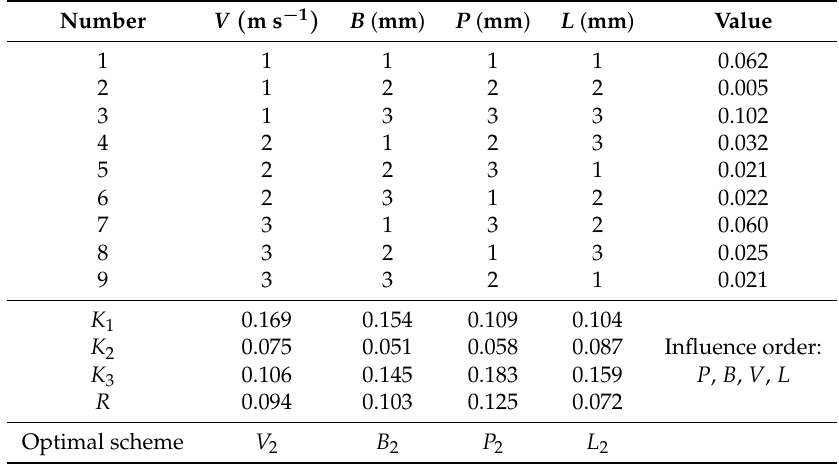
Table 4. Simulation results of index λ .